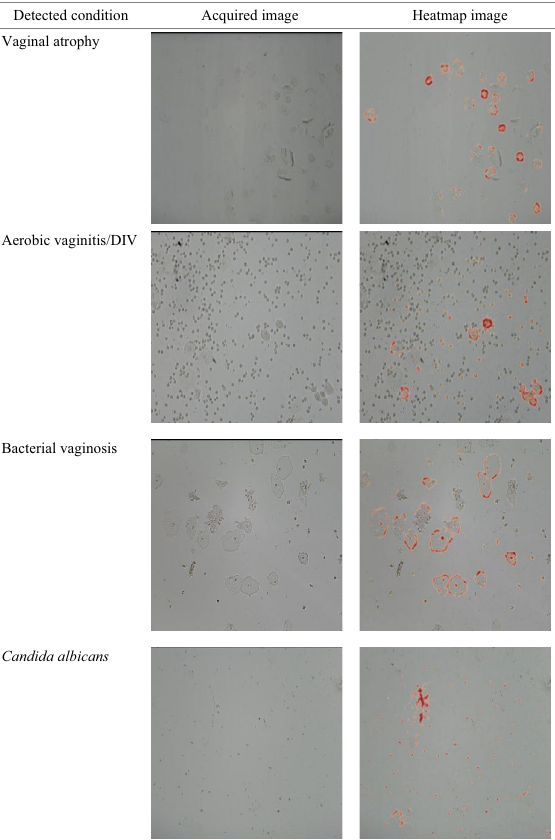
Fig. 5 Heatmap examples. Examples for microscopy heatmap images included with the investigational test